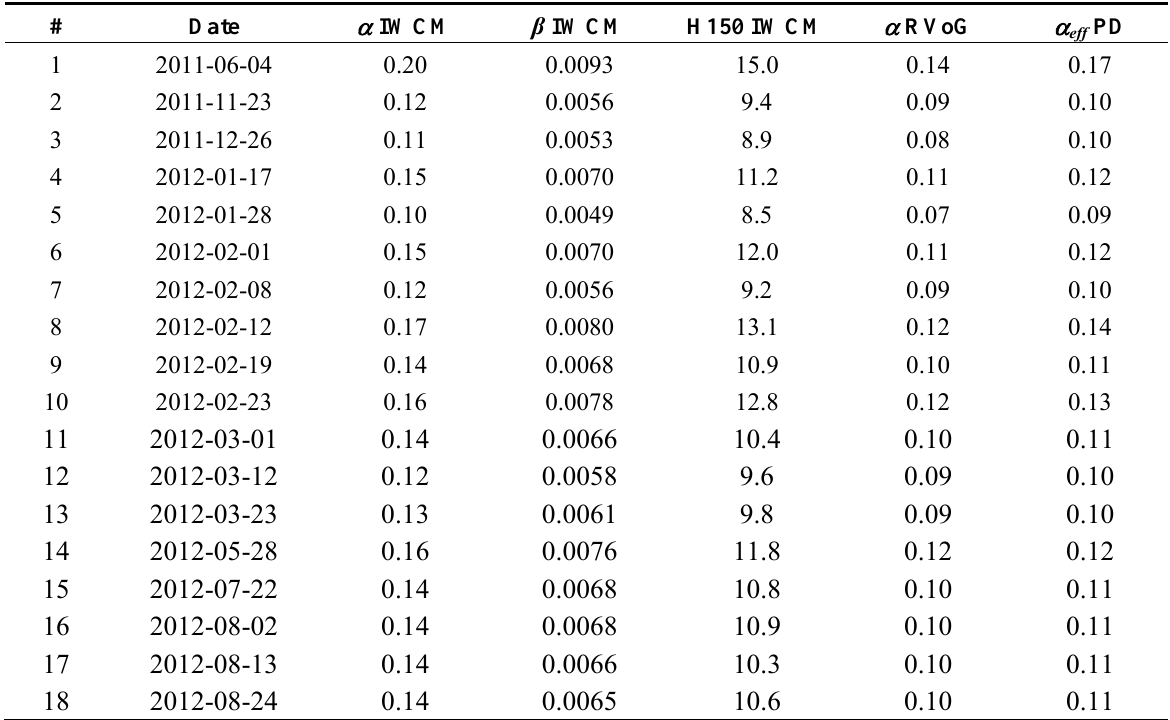
Table 3. TDM acquisition date, model parameters  , β , and modeled TDM height in m at 150 Mg/ha (H150) for IWCM, and  for RVoG and